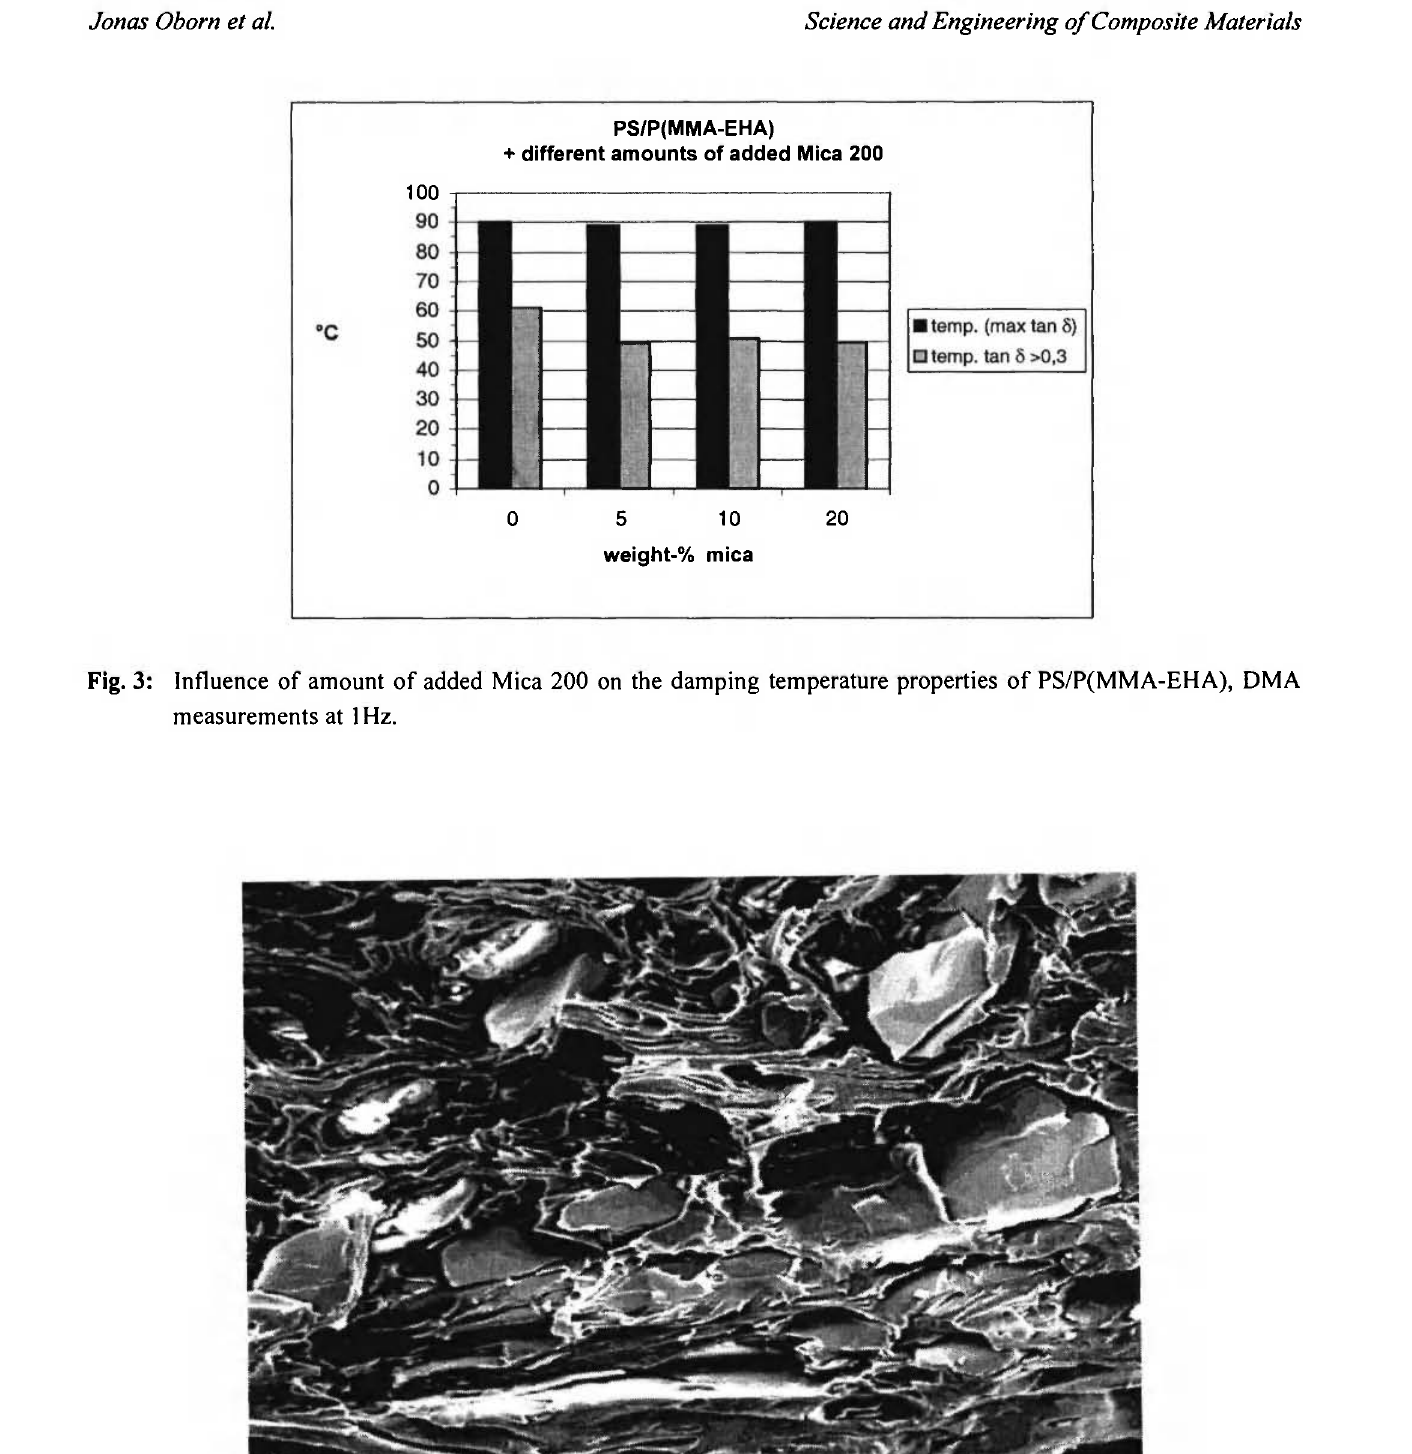
Fig. 4: SEM picture of a fracture surface where the unbonded mica particles are easily identified. PS/P(MMA-EHA) + 5% Mica